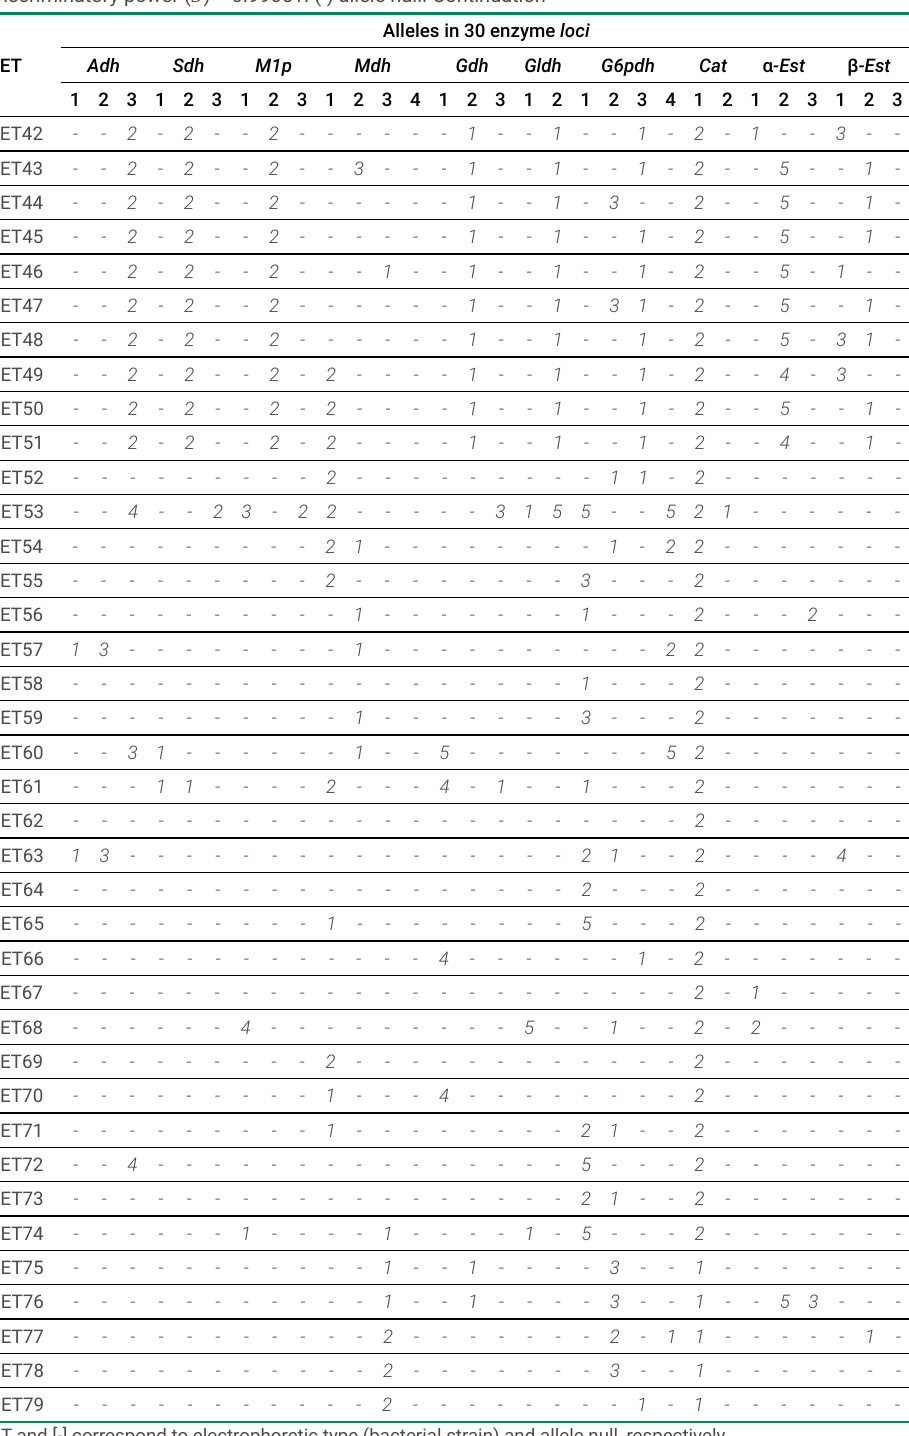
Table 2. Allele profiles of oxacillin-resistant S. aureus isolates (79 strains/ETs), sourced from odontological clinical and environment samples, and obtained for the genetic interpretation of MLEE patterns. Discriminatory power ( D ) = 0.99051. (-) allele null.